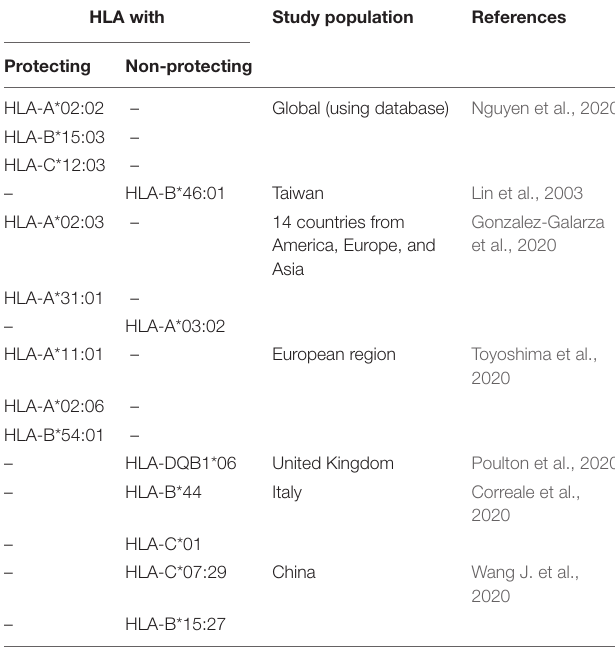
TABLE 2 | HLA reported to impact on COVID-19 incidence and case fatality around the globe. HLA